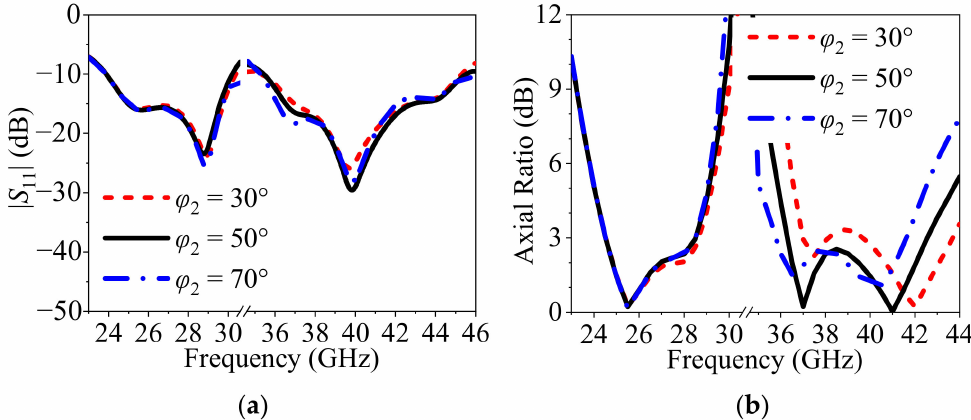
Figure 7. Simulated results of the dual-band CP DRA at different radian ϕ 2 of Slot 2: ( a ) Reflection coefficients; ( b ) ARs.